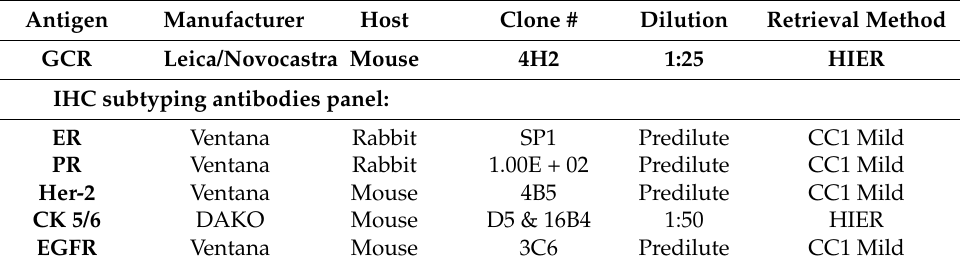
Table A1. List of antibodies for immunohistochemical